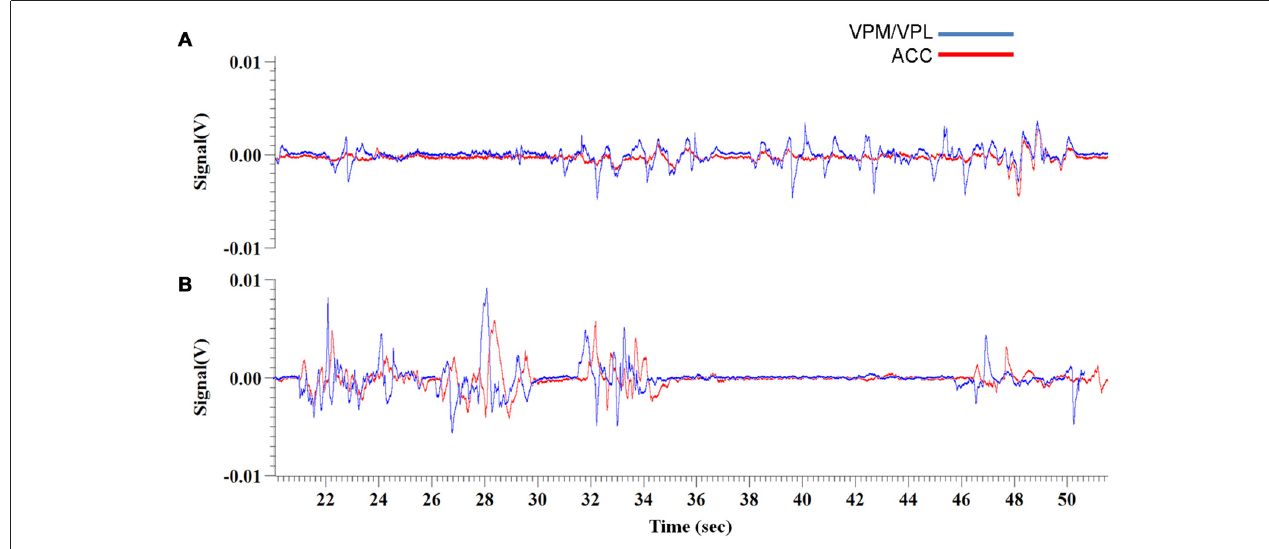
FIGURE 4 | Experiment 3, representative raw traces of LFP recordings from the VPM/VPL thalamus and ACC 1 week and 2 weeks post-VZV injection ( A,B , respectively). The representative traces show recordings from 20 min to 50 min of the 70 min total recording time.